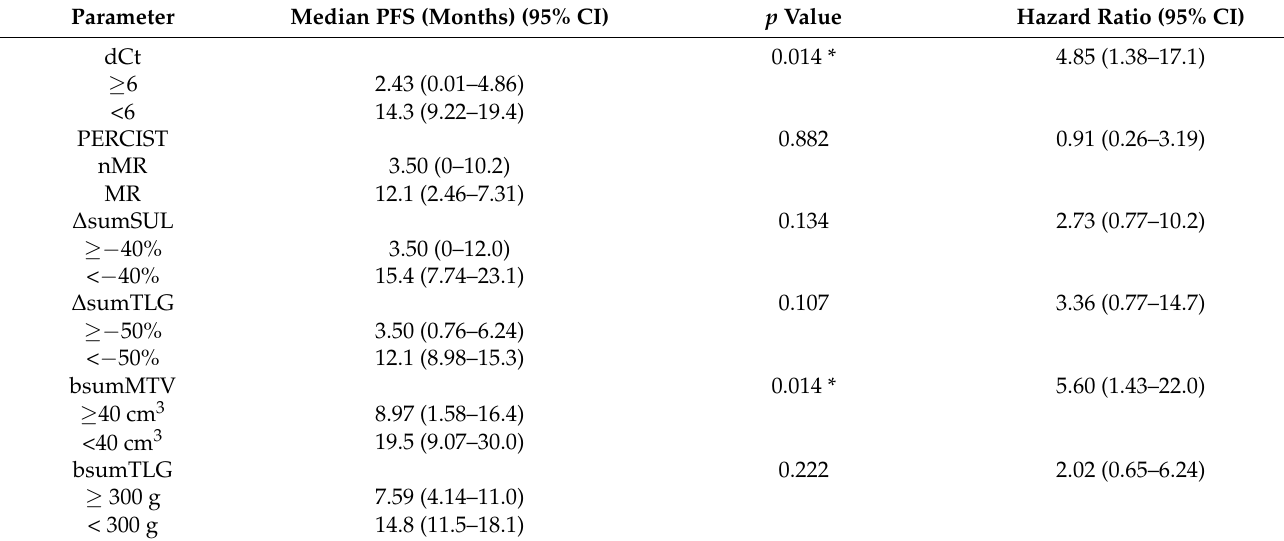
Table 3. Multivariate analysis of parameters and association with PFS ( n = 30).